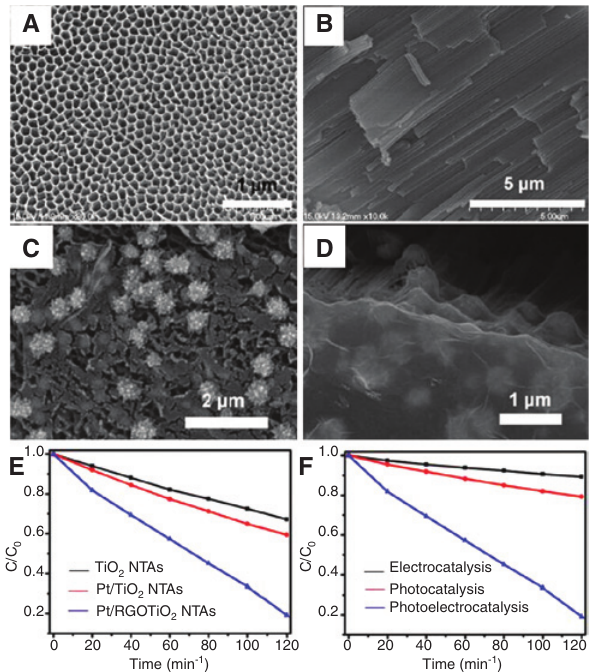
NTAs (A, B) and Pt/RGO/TiO NTAs Figure 24: SEM images of TiO 2 2 (C, D). Photoelectrocatalytic activities of TiO NTAs, Pt/TiO NTAs, 2 2 and Pt/RGO/TiO NTAs under visible light irradiation (E). Compari- 2 son of photocatalytic, electrocatalytic, and photoelectrocatalytic degradation of MB under visible light irradiation for Pt/RGO/TiO 2 NTAs (F). Reproduced from Ref. [238] with permission. Copyright American Ceramic